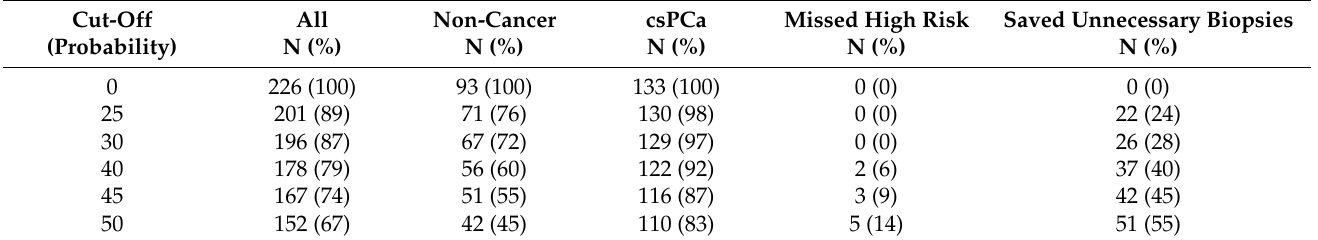
Table 9. Clinical performance of urinary zinc.